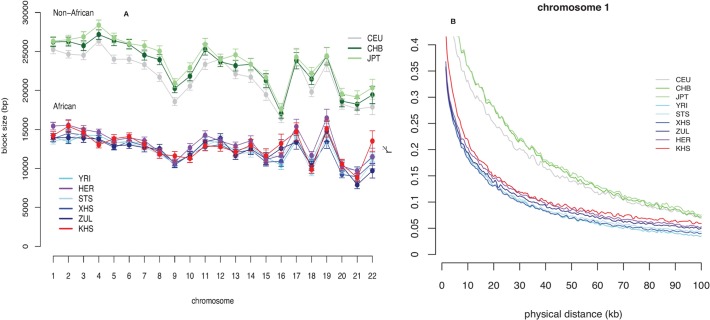
(A) Mean block sizes per chromosome and analysis panel.Error bars are twice the standard error of the mean. (B) Decay of linkage disequilibrium with physical distance along chromosome 1 for each analysis panel.